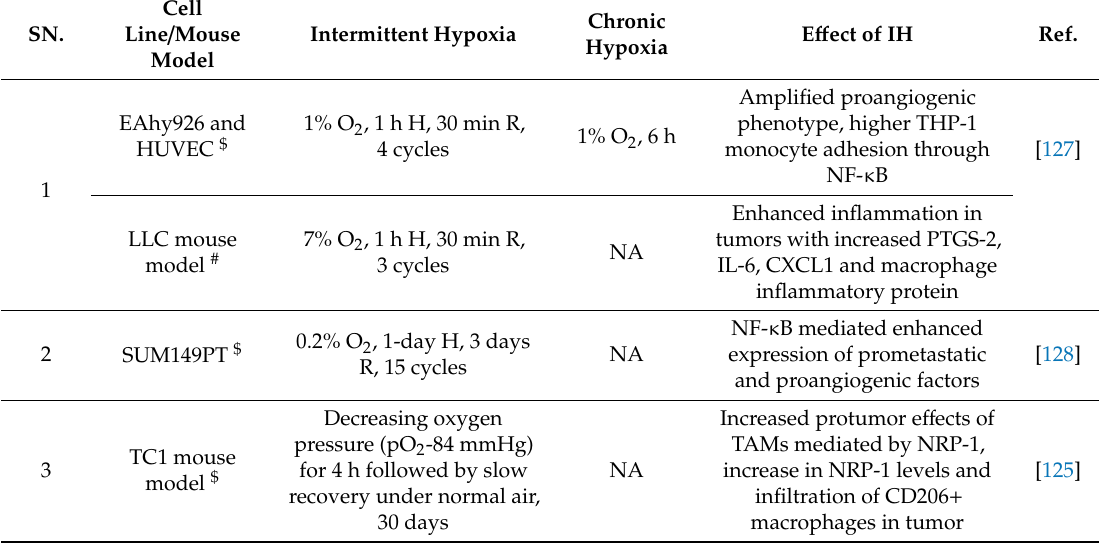
Table 6. E ff ect of IH on